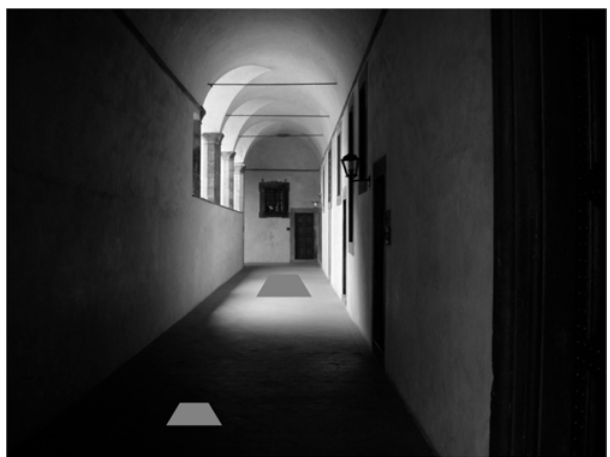
Figure 1. An everyday scene. We superimposed two trapezoidal patches that are identical in albedo and size on the picture. Interpreted as part of the picture, they differ markedly in apparent albedo and apparent size.